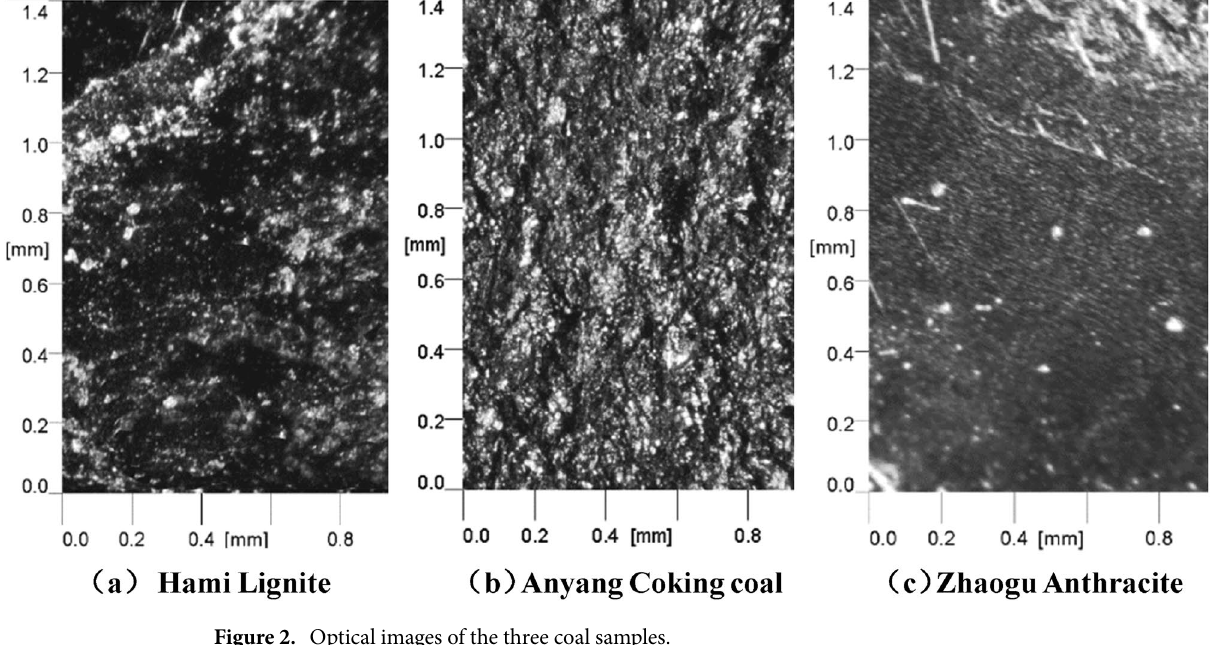
Figure 2. Optical images of the three coal samples.